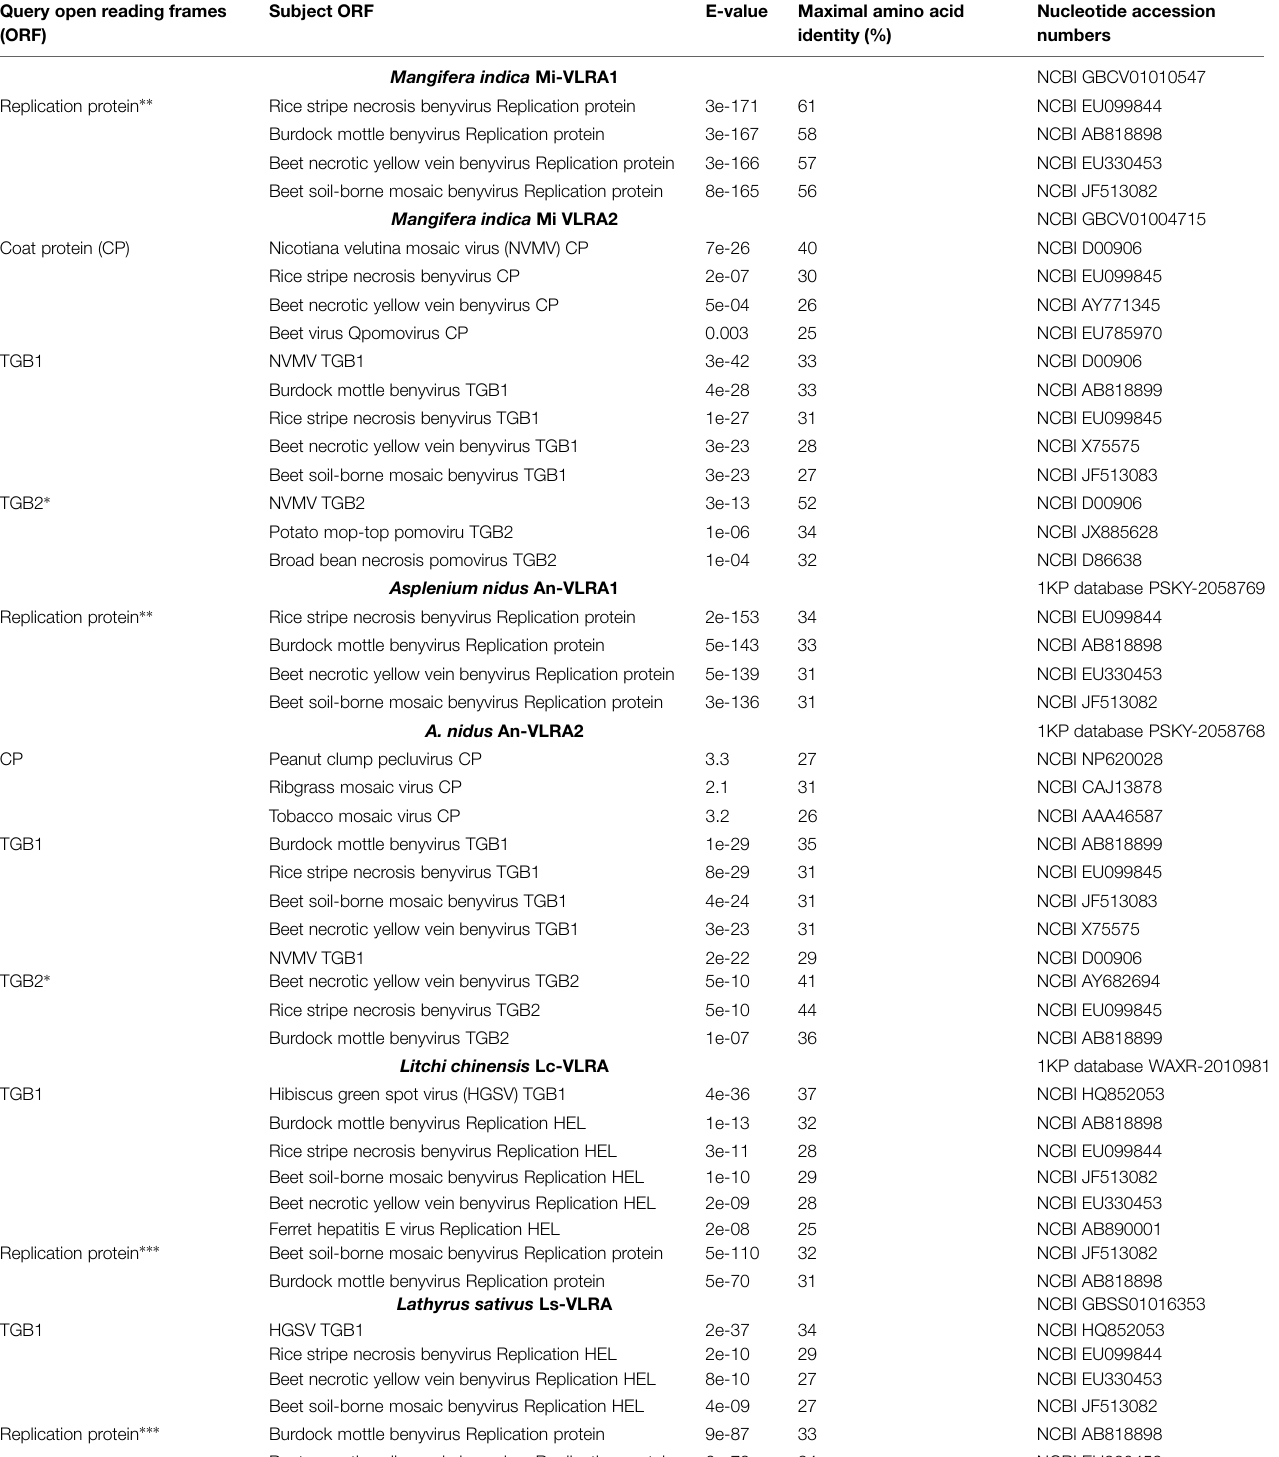
TABLE 1 | Comparisons of amino acid sequence identities of the proteins encoded by Triple gene block (TGB) containing virus genomes and virus-like RNA assemblies (VLRAs). Query open reading frames